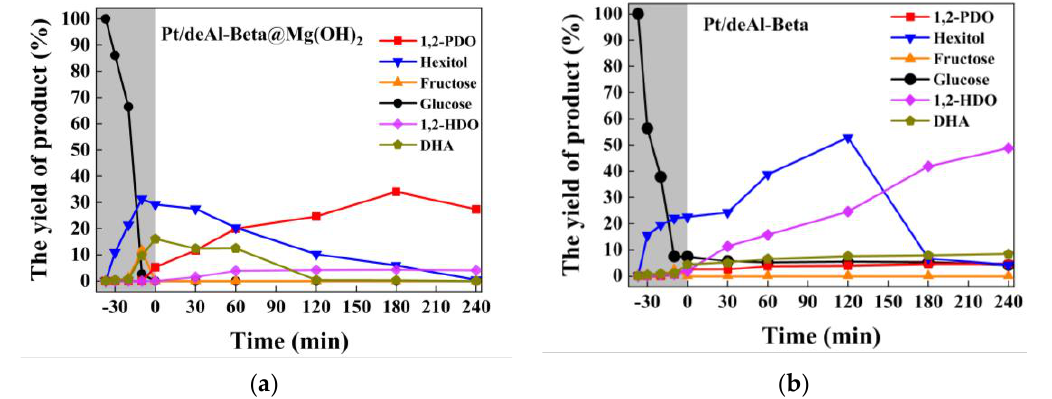
Figure 8. The time course of glucose hydrogenolysis over ( a ) Pt/deAl-Beta@Mg(OH) 2 ; and ( b ) Pt/deAl-Beta catalysts.